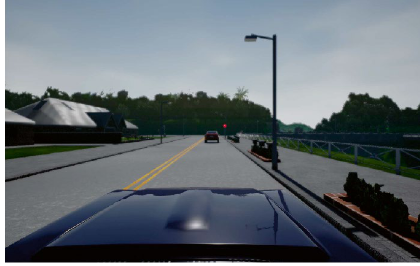
(a) Left Stereo Input Image. (b) Right Stereo Input Image.